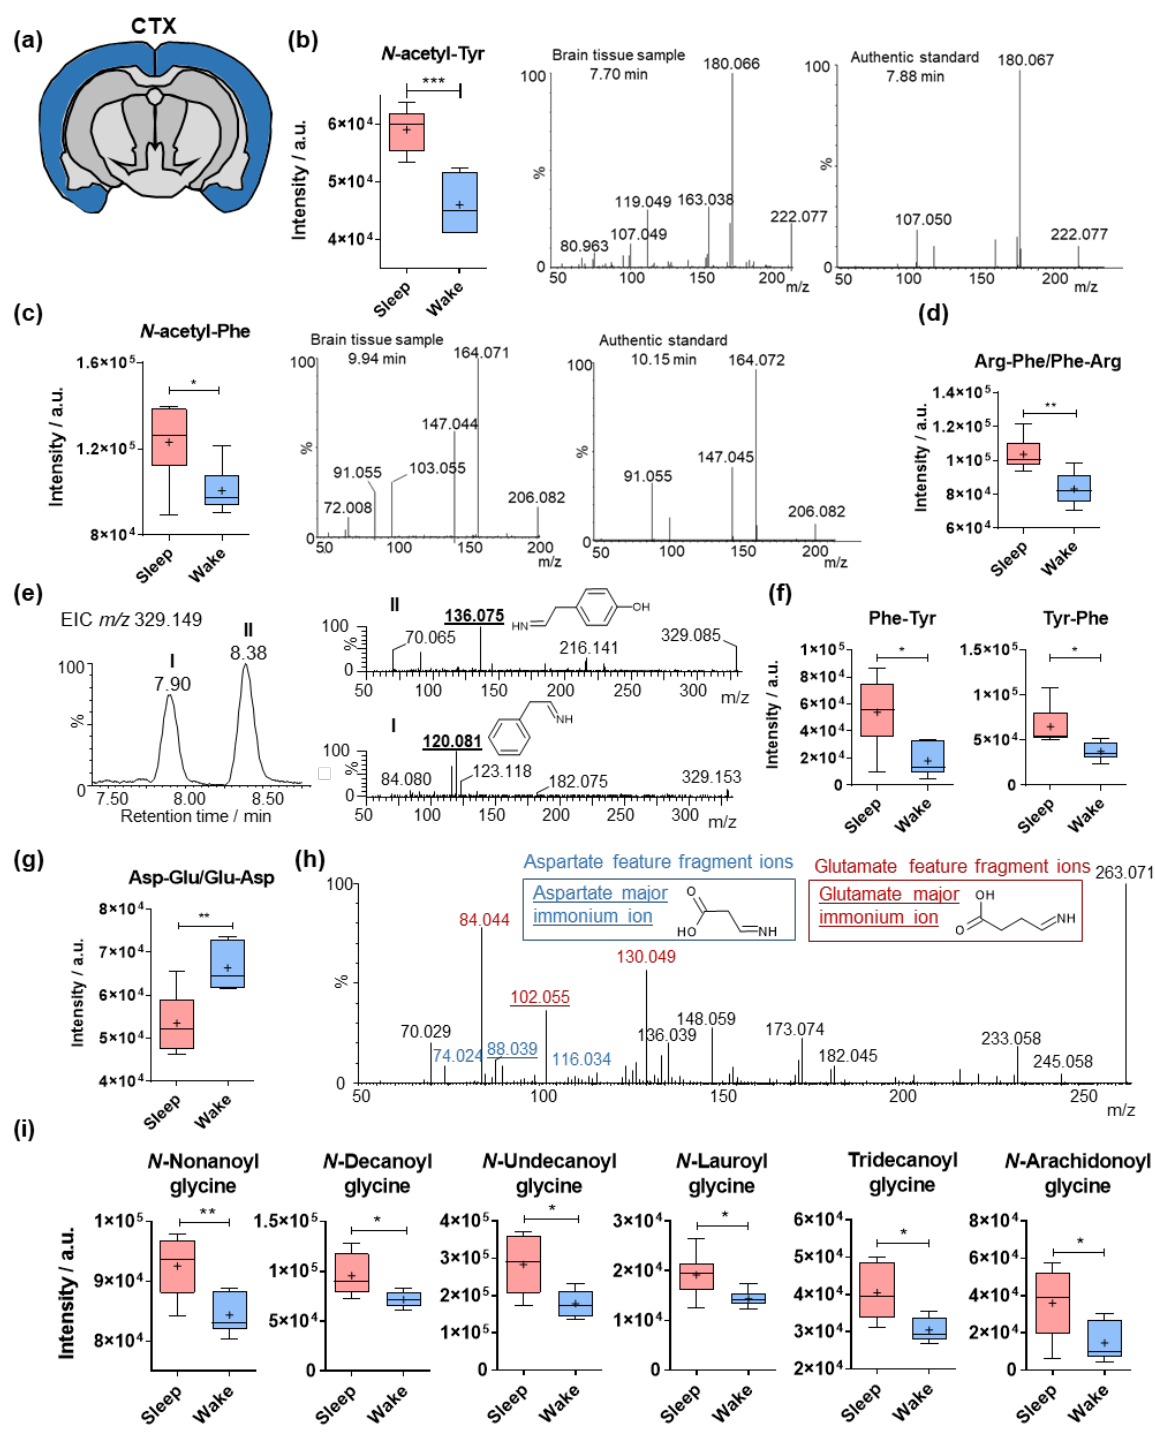
Figure 2. Sleep-specific alterations in the cortical levels of amino acid analogues. ( a ) Illustration of cerebral cortex (CTX) in a coronal mouse tissue section. ( b ) Mass spectrometric intensities of N - acetyl-tyrosine in the cerebral cortex (N = 6). Structure validation of N -acetyl-tyrosine was performed by comparison of tandem spectra collected from pooled brain sample and an authentic standard. ( c ) Mass spectrometric intensities of N -acetyl-phenylalanine in the cerebral cortex (N = 6). Structure validation of N -acetyl-phenylalanine was performed by comparison of tandem spectra collected from pooled brain samples and an authentic standard. ( d ) Mass spectrometric intensities of arginine- and phenylalanine-containing dipeptide in the cerebral cortex (N = 6). ( e ) Extracted ion chromatogram of m / z 329.149 in positive ionization mode and structural validation by tandem spec- tra collected from pooled brain sample. The 2 different chromatographic peaks at 7.90 and 8.38 min